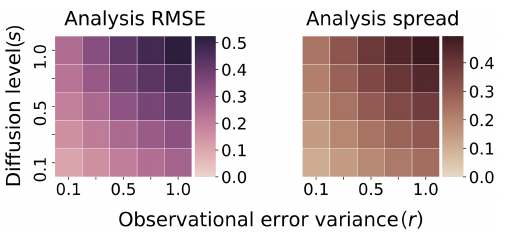
Figure 5. Truth: Taylor (cid:49) t = 10 − 3 . Ensemble: Taylor (cid:49) e = 10 − 3 . Asymptotic-average analysis for ensemble RMSE and spread of benchmark configuration. Vertical axis – level of diffusion s ∈ { 0 . 1 , 0 . 25 , 0 . 5 , 0 . 75 , 1 . 0 } . Horizontal axis – variance of observation error r ∈ { 0 . 1 , 0 . 25 , 0 . 5 , 0 . 75 , 1 . 0 }